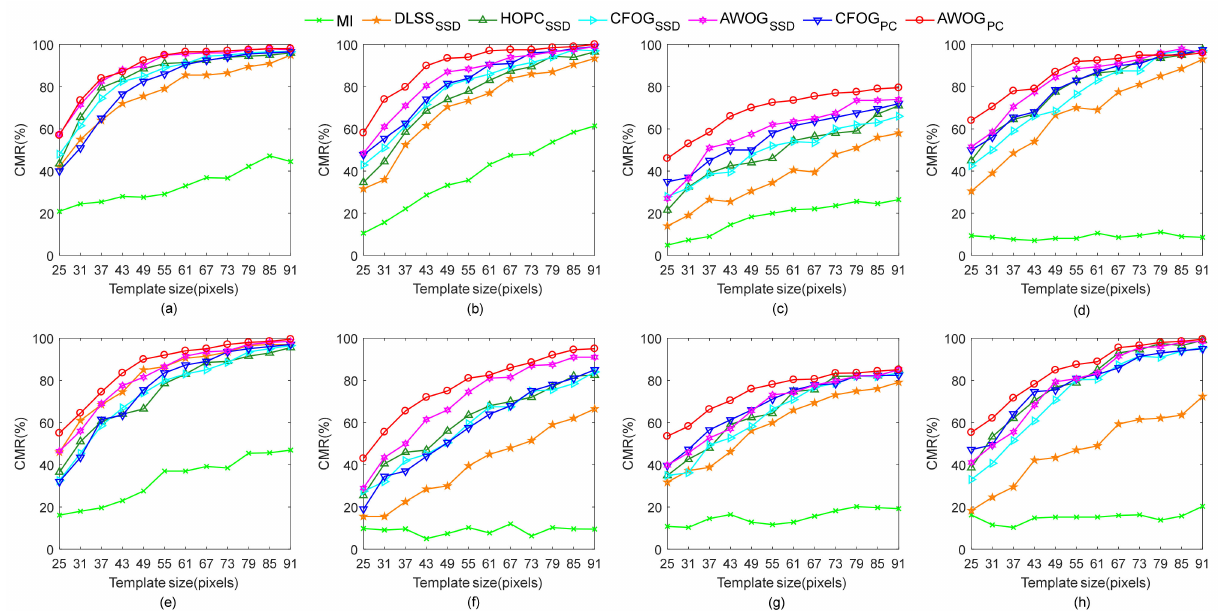
Figure 10. The correct matching ratio (CMR) results of all matching methods under different template sizes. ( a – h ) correspond to the CMR results of image pairs 1–8.